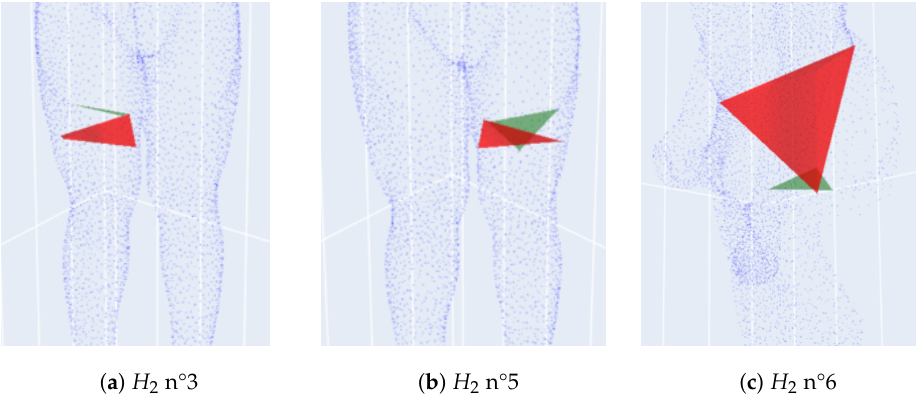
Figure 10. Three abnormal homologies at birth and death of the defective scan S2962